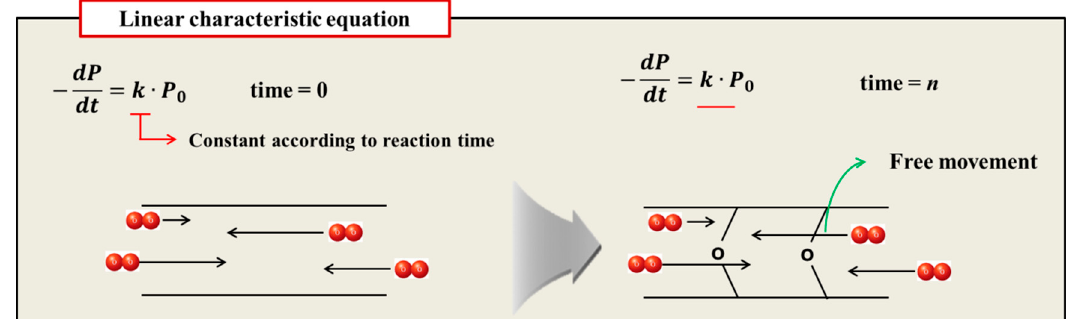
Figure 8. Crosslinking mechanism.